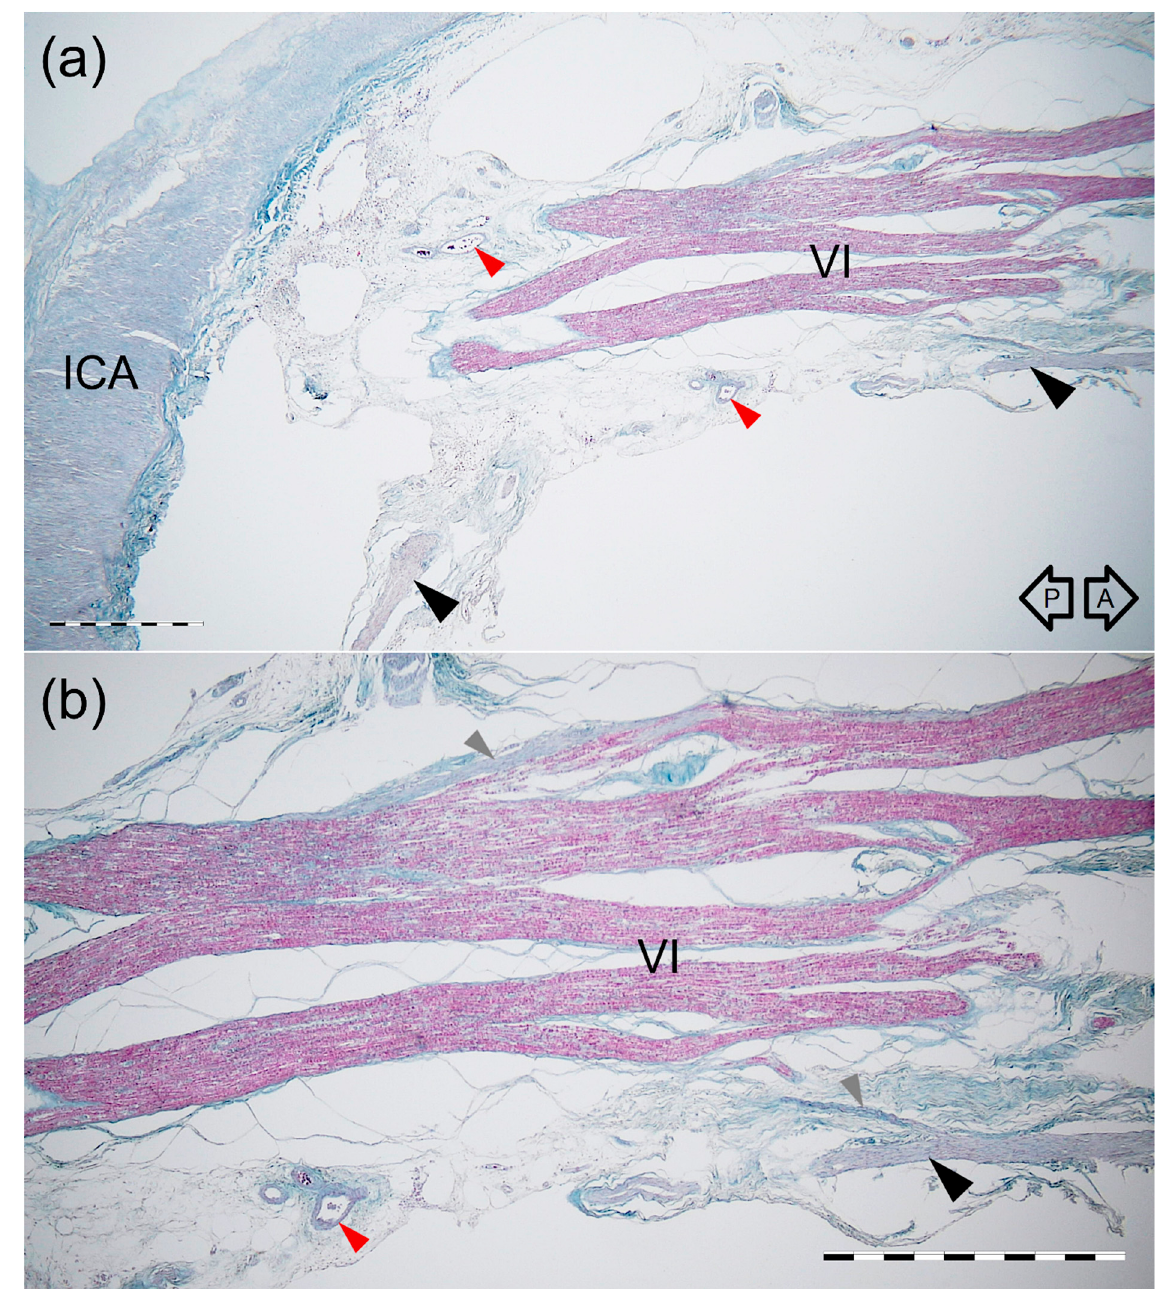
Figure 7. Histological specimen of the “pseudobranching” of the AN. Longitudinal section parallel to the nerve’s long axis. Mallory’s trichrome stain. ( a ) Panoramic view of the nerve seen under 2 × objective lens. The black arrowheads indicate the anterior bundle of sympathetic fibers which join the inferior surface of the AN. The red arrowheads show groups of small blood vessels. ICA—internal carotid artery. ( b ) Magnification of the specimen seen in figure ( a ). 4 × objective lens. The AN (VI) dividing into a few fascicles (“pseudobranching”) is characterized by a plexiform appearance with interconnections between them. The anterior bundle of the ICP (black arrowhead) is exposed on the AN’s inferior surface. The delicate bundles derived from the ICP sent communications to the AN (gray arrowheads). The red arrowhead shows a group of small blood vessels. The black arrows indicate anterior (A) and posterior (P) directions. Scale bar corresponds to 1 mm.